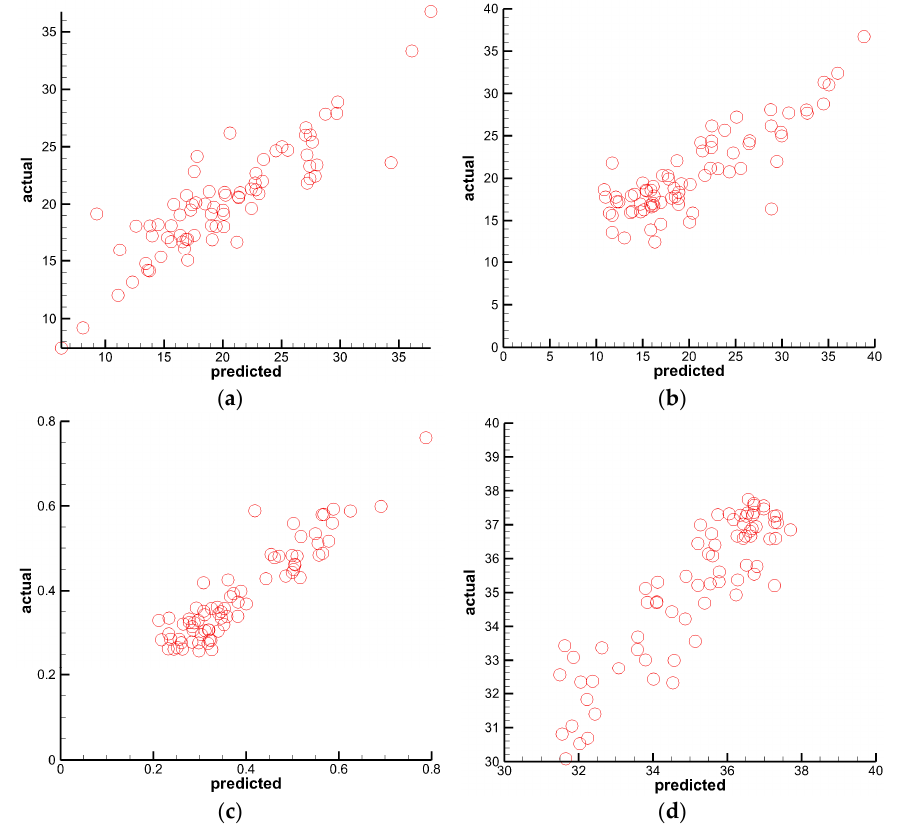
Figure 12. Scatter diagram of error analysis. ( a ) R a ( b ) R b ( c ) DC60 ( d ) M.